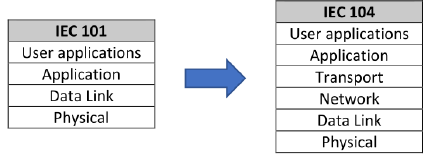
Figure 4. IEC 101 and 104